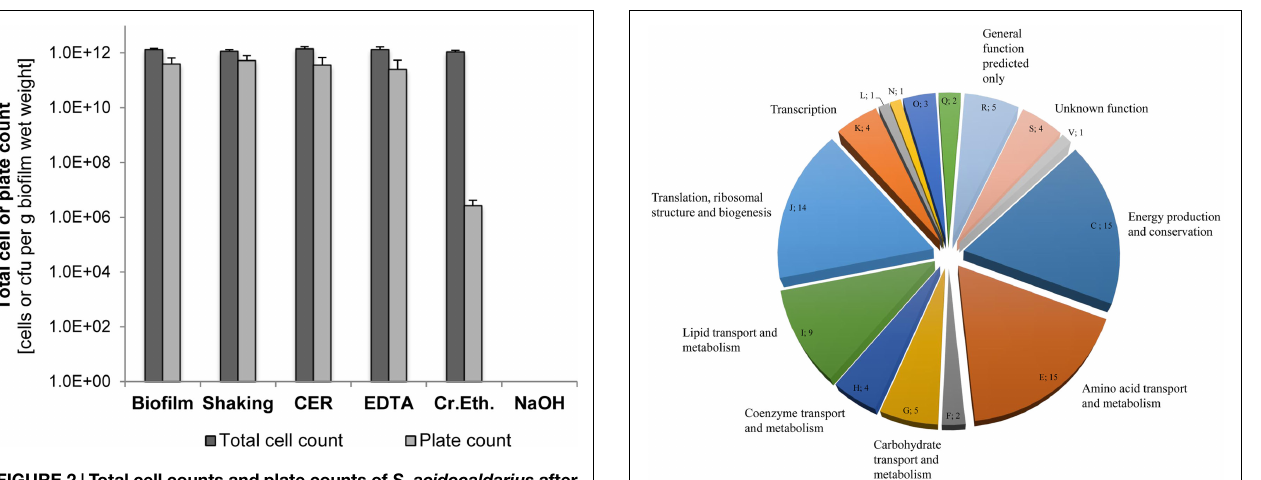
FIGURE 2 | Total cell counts and plate counts of S. acidocaldarius after EPS extraction using shaking, CER, NaOH, crown ether (Cr.Eth.), and NaOH . Measurements were performed using suspensions of intact biofilm and treated cells in phosphate buffer (pH 7.0). Total cell counts were determined via counting of DAPI-stained cells. Colonies formed on Brock medium plates were counted after incubation for 4days at 78°C ( n = 3).